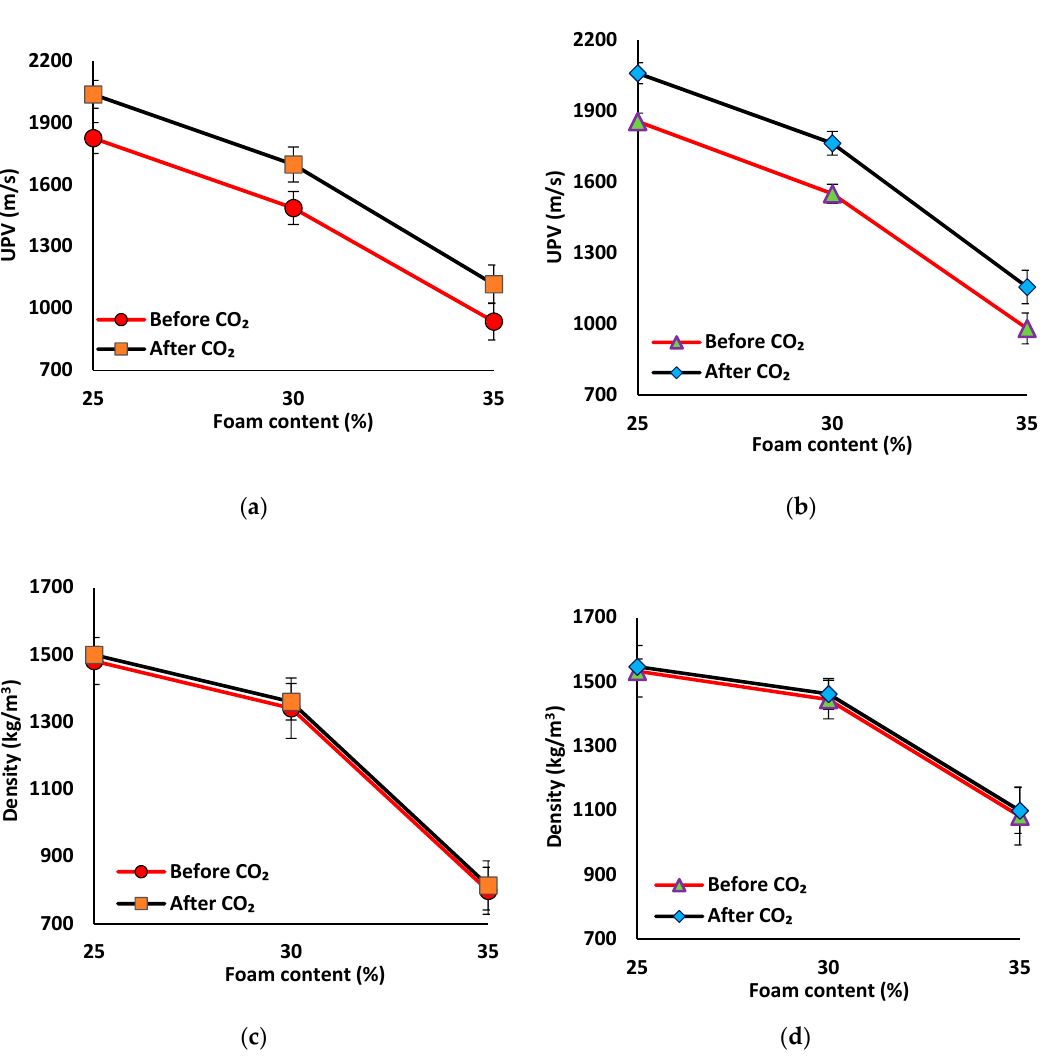
Figure 12. E ff ects of carbonation on the UPV results of mix compositions: ( a ) SW50 / GW10; Figure 12. Effects of carbonation on the UPV results of mix compositions: ( a ) SW50/GW10; ( b ) ( b ) SW30 / GW30; and density of mix compositions: ( c ) SW50 / GW10; ( d ) SW30 / SW30/GW30; and density of mix compositions: ( c ) SW50/GW10; ( d ) SW30/GW30.